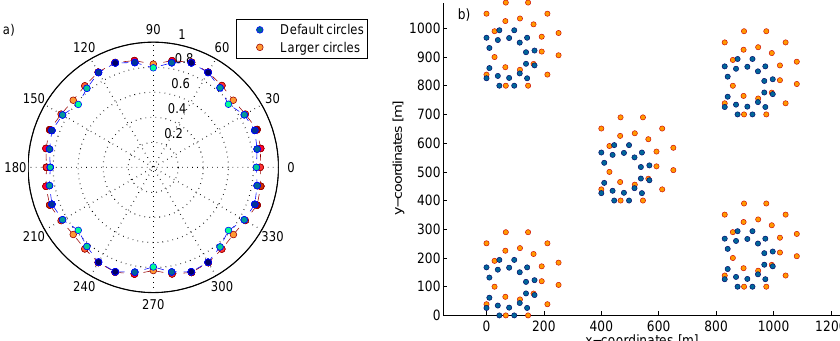
Figure 2. ( a ) Interaction factor q (radial coordinate in the plot) of an array with 100 WECs (shown in Figure 2b), as a function of incident wave angle. An angle of zero degrees corresponds to the configuration in Figure 2b and Figure 3 with the incident wave along the x -axis. The blue/cyan points correspond to the default smaller circles, whereas the red/orange points correspond to the larger circle configuration. ( b ) Configuration of the two farms with 100 WECs in five double circles with different inner and outer radii.